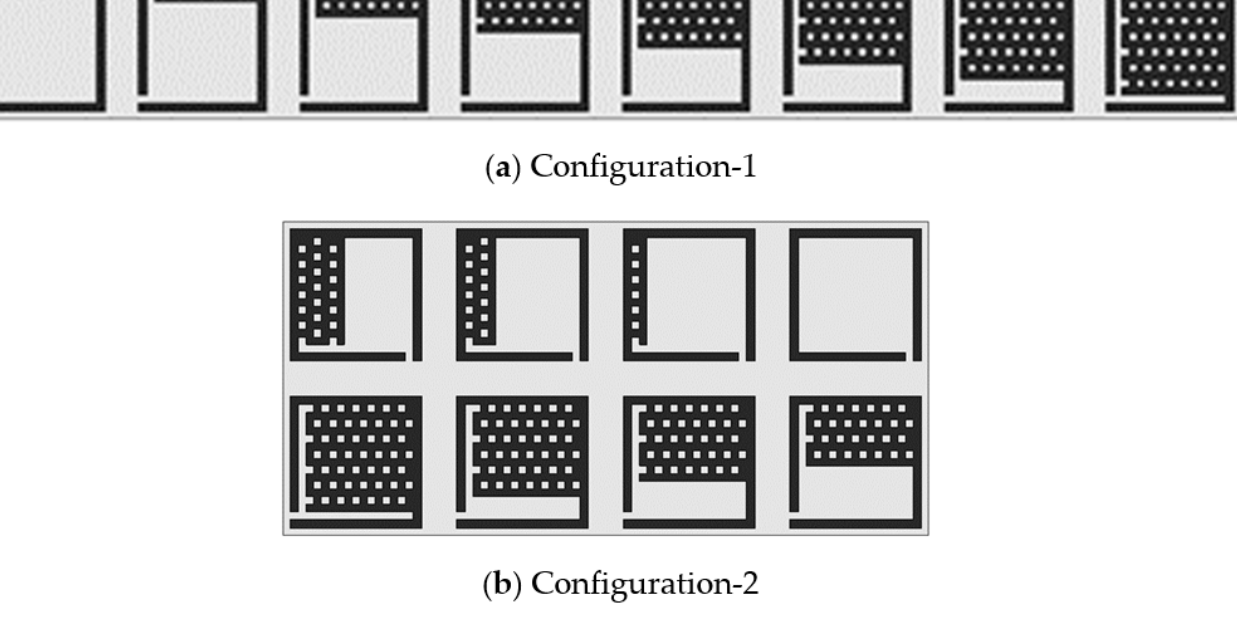
Figure 6. Configuration setting of loaded open-loop resonators on front side of the substrate only: ( a ) Configuration-1 (8 × 1 matrix); ( b ) Configuration-2 (4 × 2 matrix).